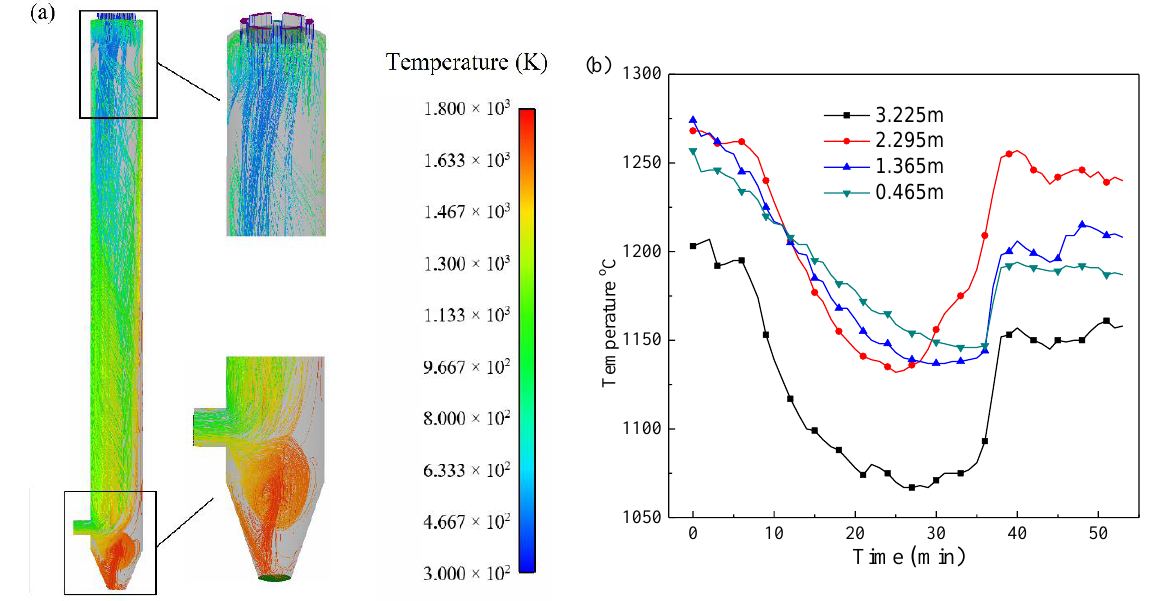
Figure 4. Temperature profiles of the furnace along with a closer view: ( a ) temperature profile for simulation and ( b ) temperature profile for experimental gasifier at different heights as a function of time (min).